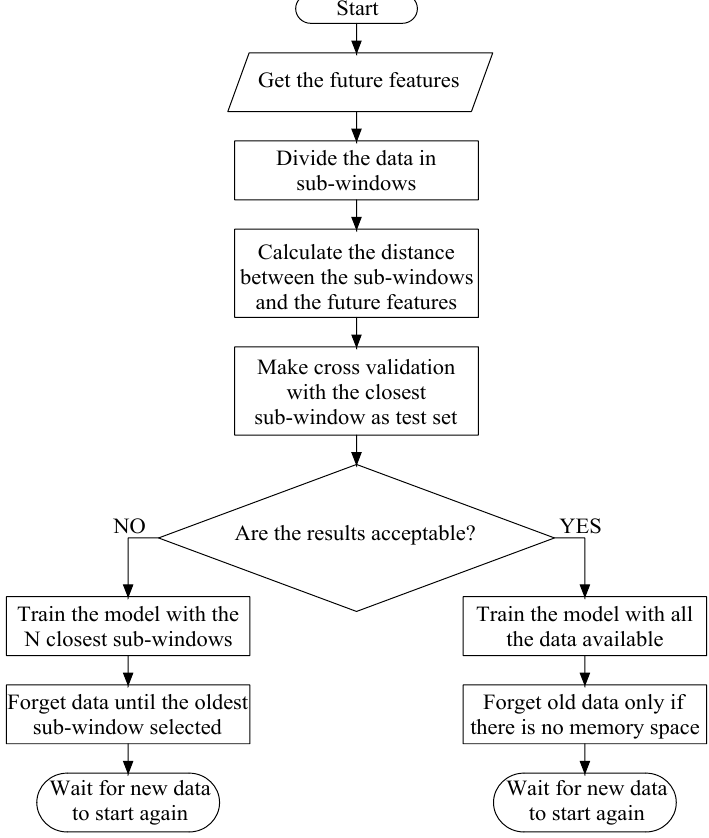
Figure 3. Flowchart of the proposed